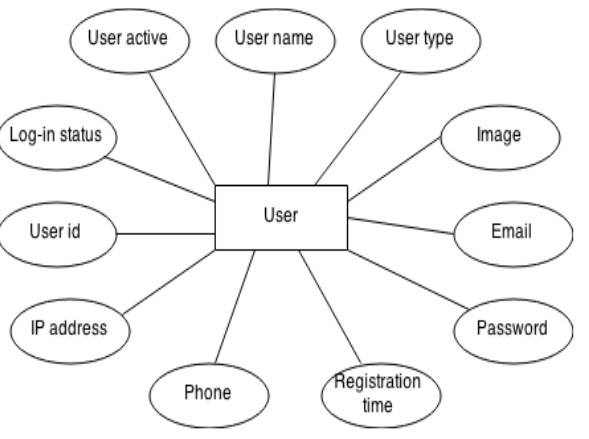
Figure 4. Meter reading attributes for new